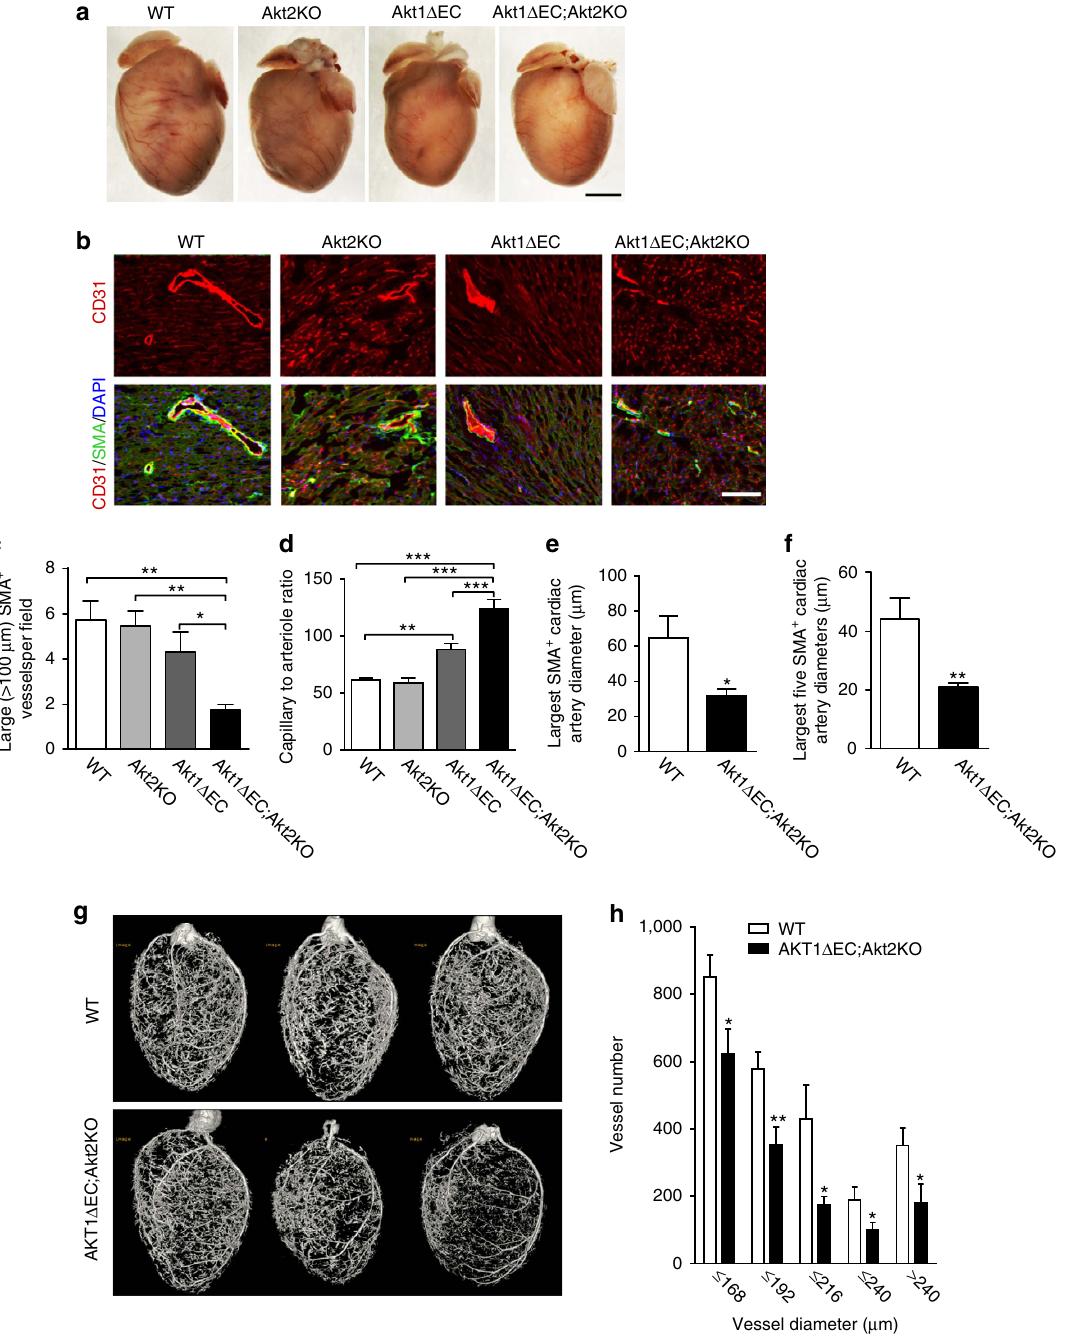
Figure 1 | Vascular abnormalities triggered by Akt1 deletion. ( a ) Representative images of WT, Akt2KO, Akt1 D EC and Akt1 D EC;Akt2KO hearts after tamoxifen treatment for 4 weeks (5 days i.p. tamoxifen injection followed by 3 weeks tamoxifen diet, 8–9 weeks old). Scale bar, 2mm. ( b ) Representative images of WT, Akt2KO, Akt1 D EC and Akt1 D EC;Akt2KO heart sections after 4 weeks of tamoxifen treatment stained for CD31 (red), SMA (green) and DAPI (blue). Scale bar, 100 m m. ( c , d ) Quantification of 4 100 m m (large) SMA þ vessels per field and capillary (CD31 þ SMA (cid:2) ) to arteriole (CD31 þ SMA þ ) ratio represented as mean ± s.e.m. ( n ¼ 4). ( e , f ) Quantification of the largest and top five largest cardiac artery diameters measured in the heart sections represented as mean ± s.e.m. ( n ¼ 5–6). ( g ) Representative microCT images for WT and Akt1 D EC;Akt2KO hearts after 10 weeks of tamoxifen treatment (5 days of i.p. tamoxifen injection followed by 9 weeks of tamoxifen diet, 14–15 weeks old). ( h ) Quantification of the numbers of vessels within each diameter bin represented as mean ± s.e.m. ( n ¼ 5–7). * P o 0.05, ** P o 0.01 and *** P o 0.005 by one-way analysis of variance ( c , d ) or Student’s t -test ( e – h